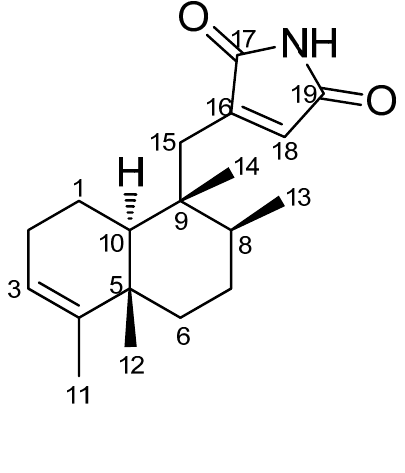
Figure 1. The chemical structure of dysidinoid A ( 1